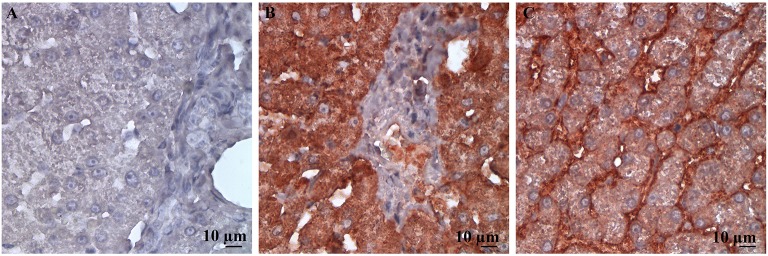
High power (500X) images of canine liver tissue labeled immunohistochemically with (A) the isotype control antibody; (B) LDL-R antibody; and (C) SR-B1 antibody. The staining pattern for LDL-R is diffusely strongly positive in hepatocytes imaged in (A), as expected. Similarly, staining pattern is membranous and weakly diffuse in the cytoplasm of hepatocytes in (B), an expected finding for SR-B1.